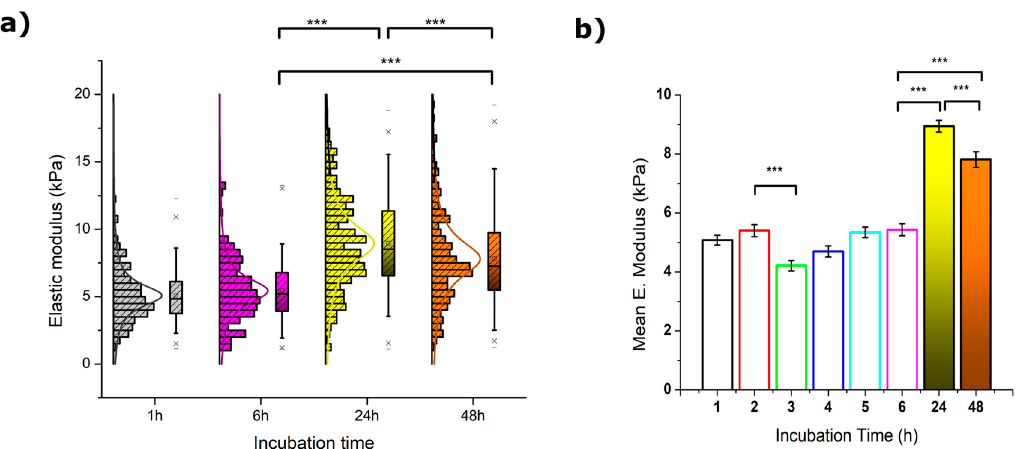
Figure 2. ( a ) Statistical calculation of Young’s moduli from MCF-7 cells ( N > 100) exposed to 50 µM resveratrol during 1 ( grey ), 6 ( pink ), 24 ( yellow ), and 48 h ( orange ). The crosses (x) indicate achievement of either the 1% or 99% of the total population, short lines (-) reflect both the maximum and minimum values obtained, the square ( □ ) in the box plot represents the mean value, and the box-splitting horizontal line gives the median. ( b ) Variation of the mean values over the entire range measured, where the deviation is the standard error of the mean. Significance of the variations in the p < 0.001 level is indicated accordingly by (***) symbol.